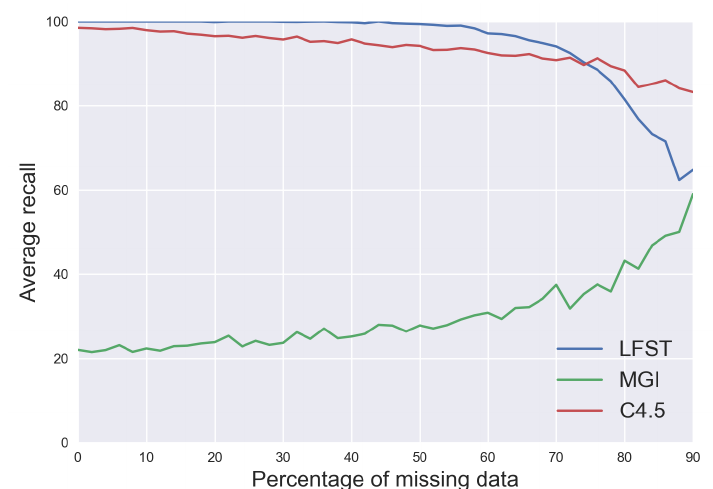
Figure 10. Comparison of the average recall in CubeWorld.